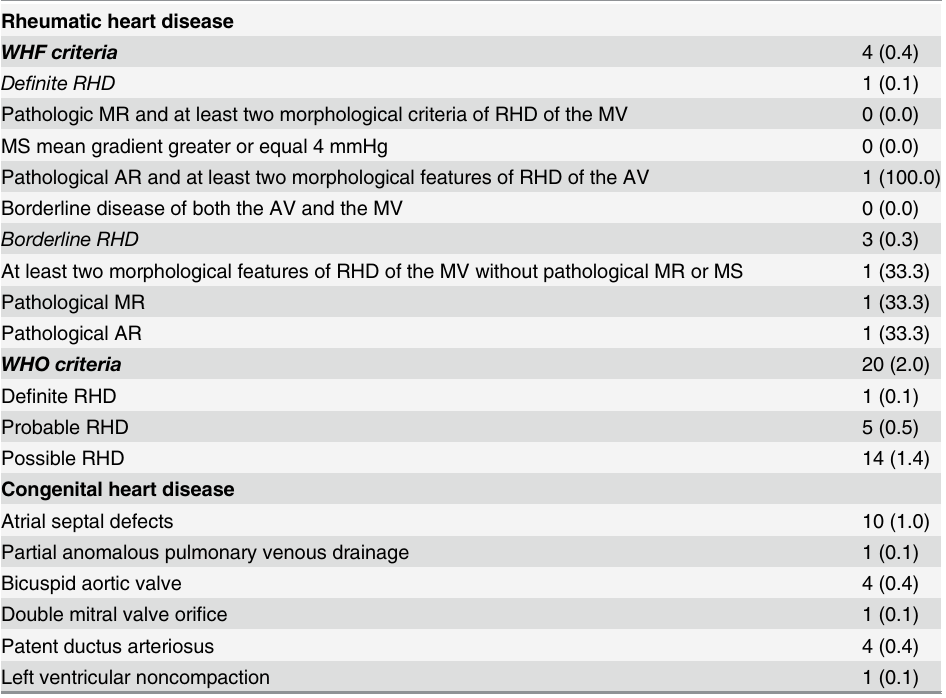
Table 3. Echocardiographic